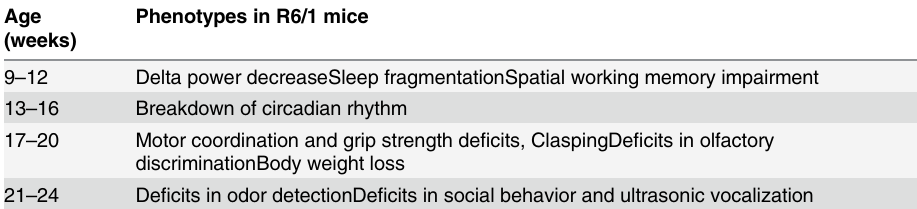
Table 2. Summary of multi-domain phenotypic changes across age in R6/1 mice.